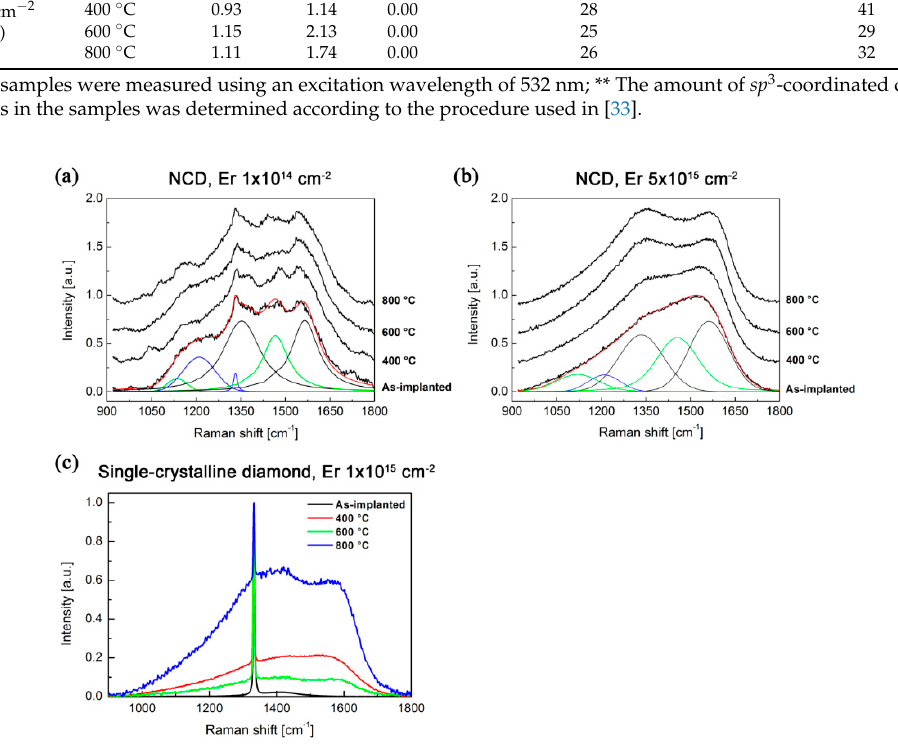
Figure 5. The Raman spectra of the single- and nano-crystalline diamond samples implanted with various fluences and annealed at temperatures ranging from 400 °C to 800 °C. The deconvolution analysis of NCD samples is shown for the spectra of the as-implanted NCD sample (the description of the particular deconvolution bands is explained in Figure 4). The single-crystalline sample is normalized to (0, 1) for better comparison.